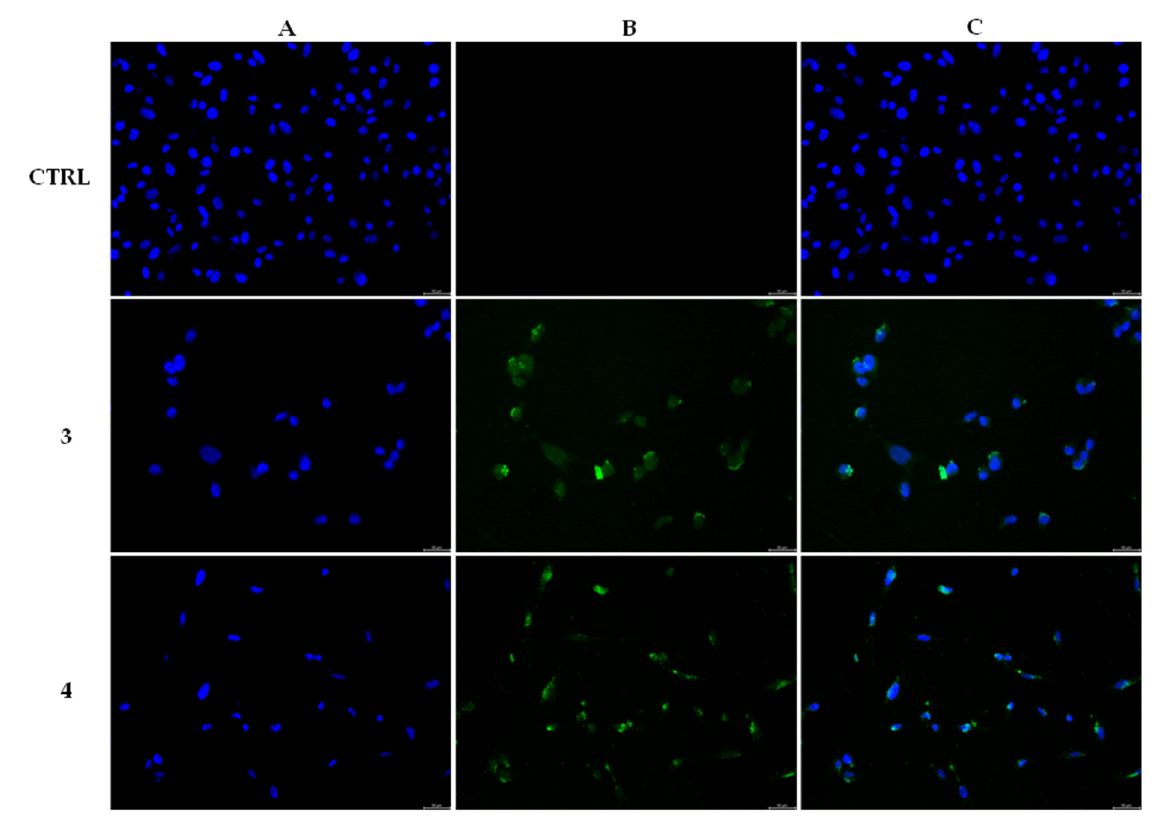
Figure 6. Tunel Assay. MDA-MB-231 breast cancer cells were treated with compounds 3 and 4 at the concentration equal to their IC 50 values or with vehicle (CTRL) for 24 h. Then they were exposed to the TdT enzyme, further processed (see experimental section for more details) and visualized under a fluorescence microscope (20x magnification). Panels A: DAPI, λ ex/em = 350 nm/460 nm. Panels B: CF TM 488 A, λ ex/em = 490 nm/515 nm. Panels C show the overlay channels.